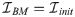
Cell migration from a cell bead in substrates of different collagen density.Final configurations of simulated vascular networks at time Tmax = 1.0 (corresponding to 500 minutes) of individual simulations used in reproducing the results of the polarisation experiment in [38]. Maximum collagen density (A)
cmax = 0.1, (B)
cmax = 1.0, (C)
cmax = 1.7, (D)
cmax = 3.0. The VEGF linear gradient starts with 0 ng/ml at y = 0 and increases up to 5 ng/ml at y = 125 μm. Central bead initial and basement membrane conditions, IBM=Iinit, are outlined by a black thick line on each plot. Colour bars indicate Delta ligand concentration. Numerical simulations were performed using Setup 3 from S4 Table. Parameter values are listed in S1 and S2 Tables for subcellular and cellular/tissue scales, respectively. For a movie of the numerical simulation, see S2 Movie.